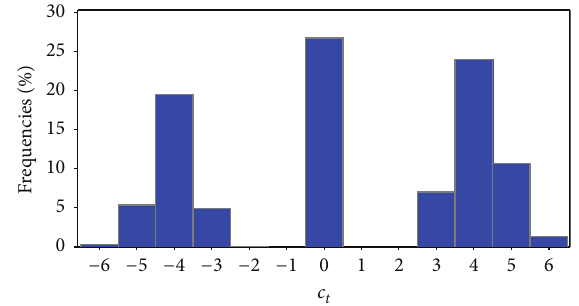
Figure 1: Frequency distribution of consensus variable 𝑐 𝑡 for the US stock index (Datastream) calculated in the period of Janunary 1, 1993, to March 31, 2008.